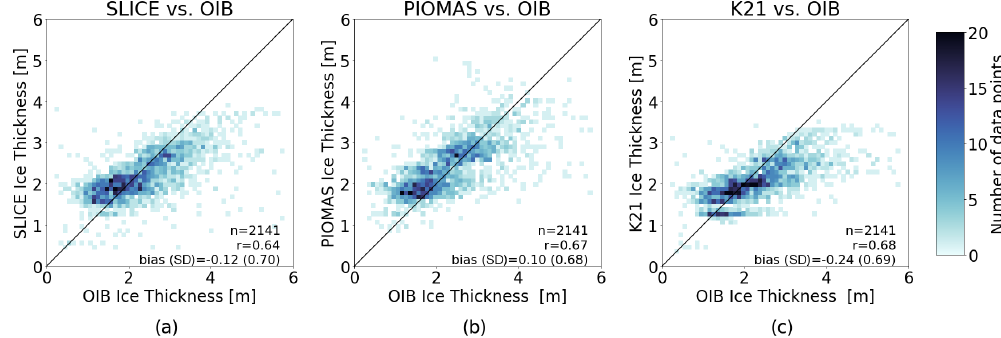
Figure 6. OIB thickness versus (a) SLICE, (b) PIOMAS, and (c) Kang et al. (2021) data including number of data points, linear correlations, and bias (standard deviation). All three have similar linear